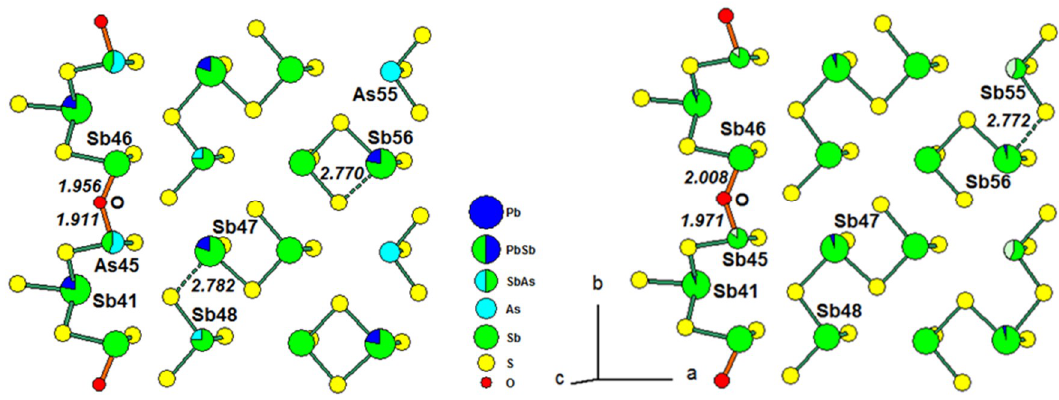
Figure 5. (Sb,As)–S polymerization in C2 rods from Pollone (left) and Monte Arsiccio